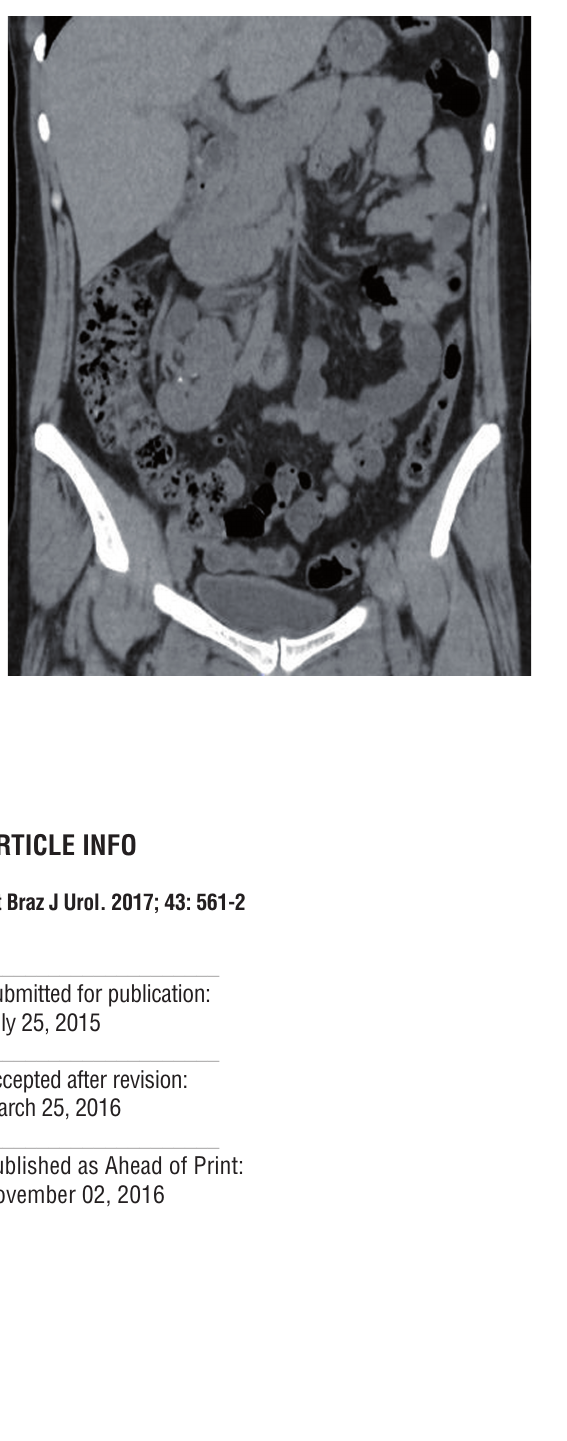
figure 3 - computed tomography scan of supernumerary kidney with its own blood supply and collecting